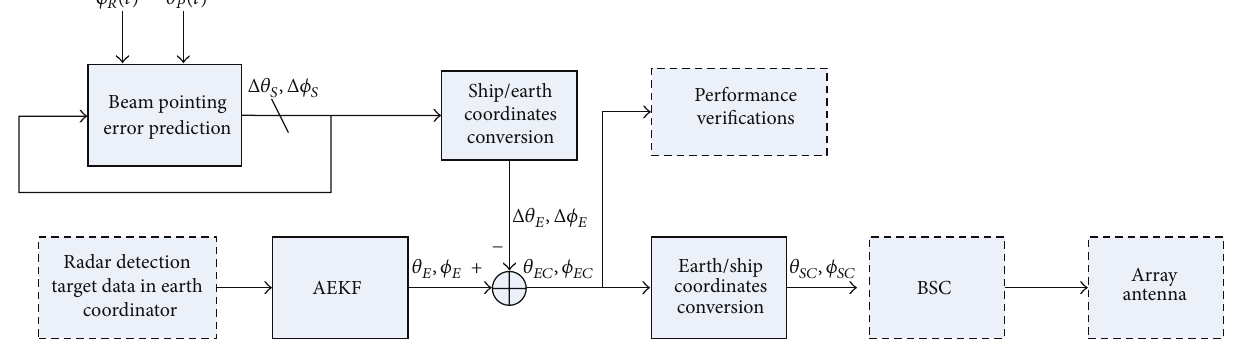
Figure 2: System diagram of rotational motion compensation for AEKF of shipborne phased array radar.